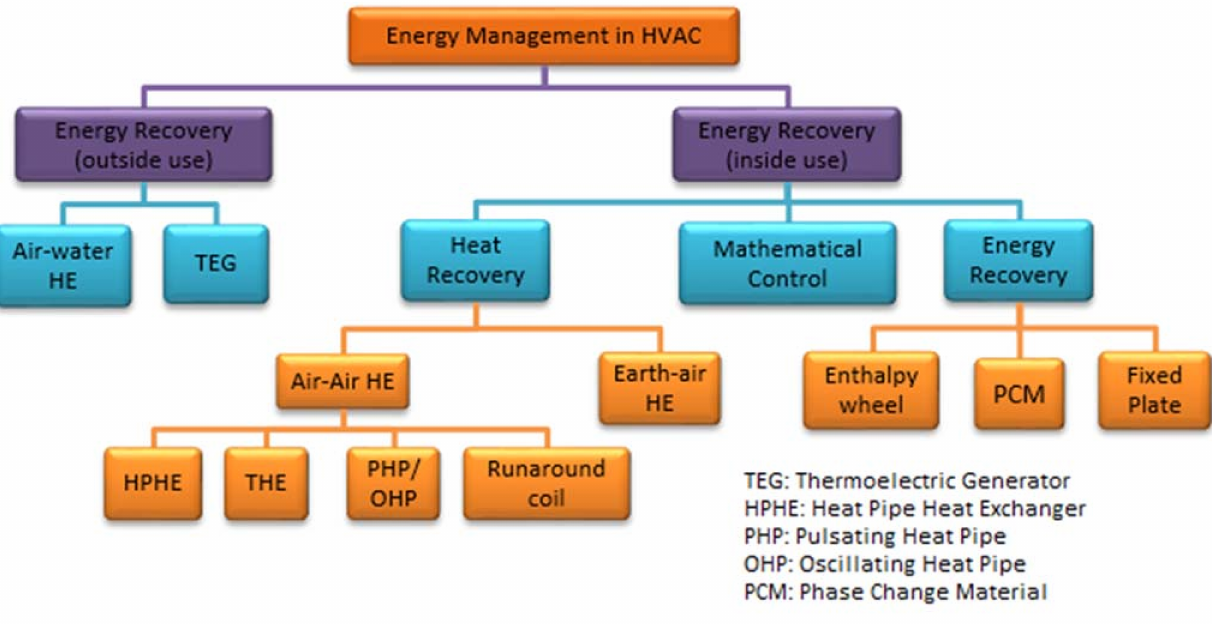
Figure 5. Energy management classified into